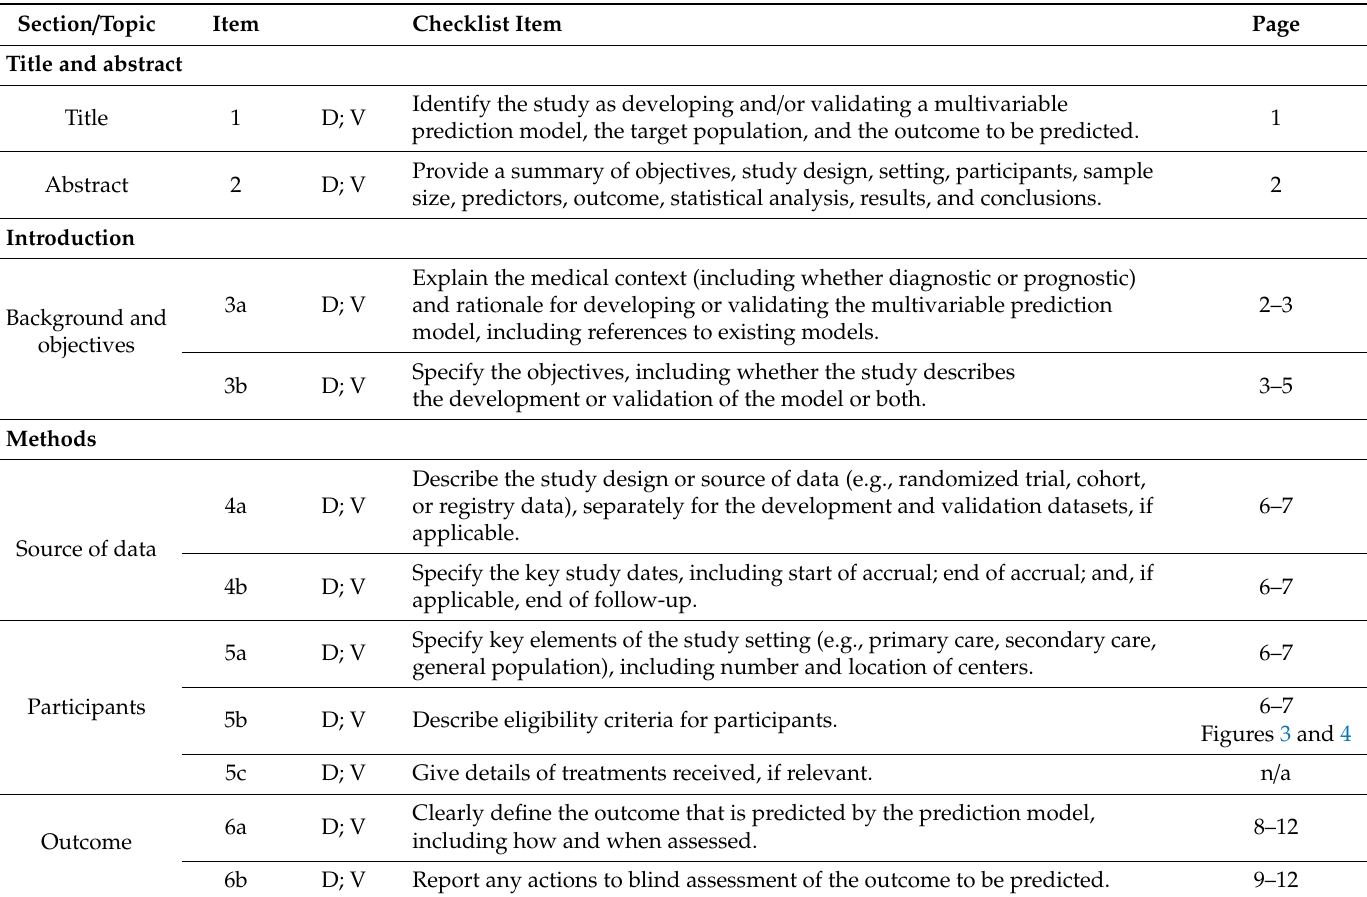
Table A1. Transparent Reporting of a multivariable prediction model for Individual Prognosis or Diagnosis (TRIPOD) Checklist: Prediction Model Development and